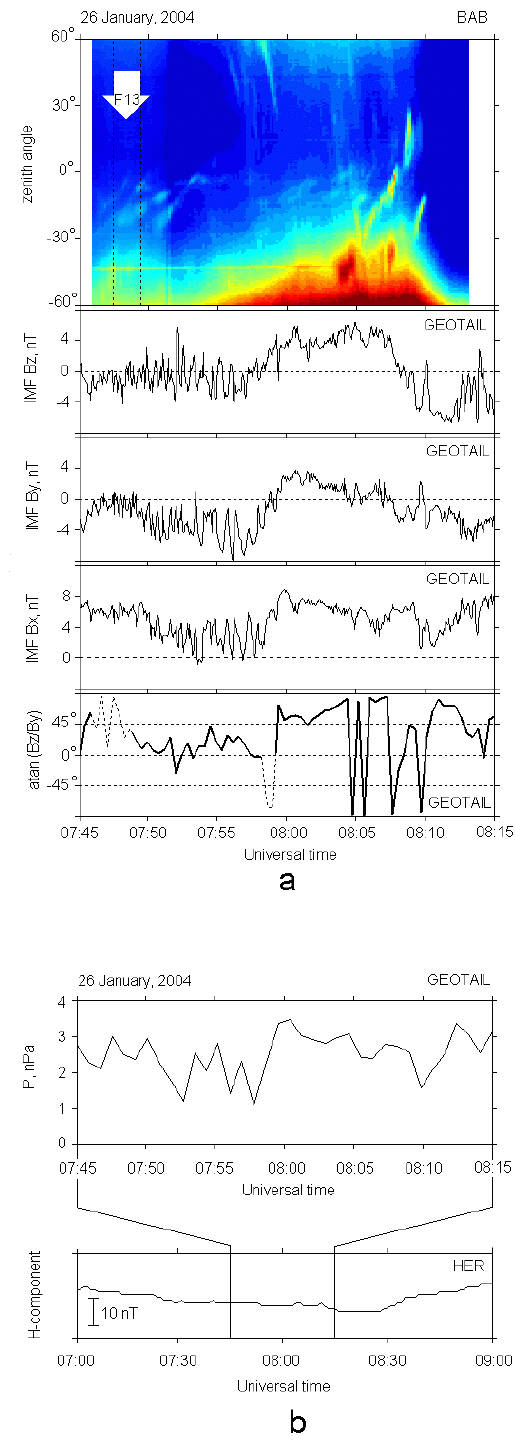
Fig. 1. Auroral activity above the BAB (top panel) and the conditions in interplanetary medium as measured by the Geotail satellite. The white arrow indicates the time of DMSP F13’s passage through the TV camera field of view. The bottom panel shows the magnetic variations at the low-latitude Hermanus observatory.